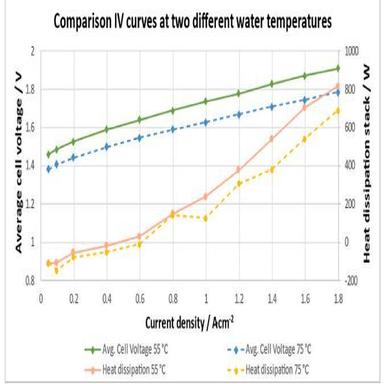
Polarization curves and heat dissipation of the stack at two different water temperatures.